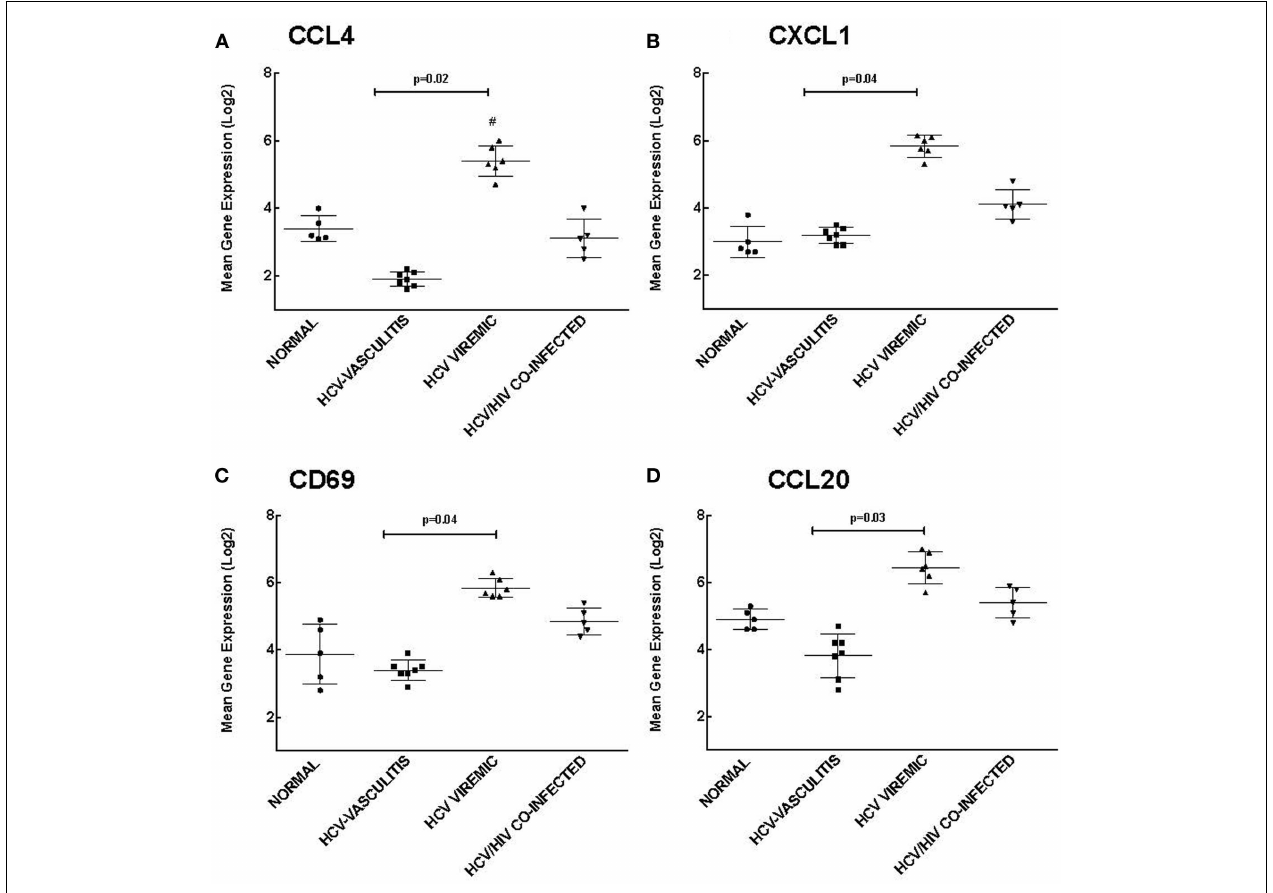
calculated in comparison to that of GAPDH .The expression of CCL4 (A) , CXCL1 (B) , CD69 (C) , and CCL20 (D) were higher in the HCV monoinfected cohort compared to the other groups ( p = 0.02, 0.04, 0.04, and 0.03, respectively compared to HCV